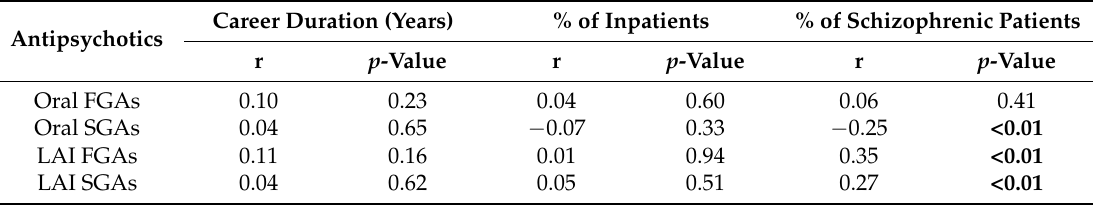
Table 2. Correlations between type of antipsychotic used in schizophrenic patients and practice characteristics of clinicians.